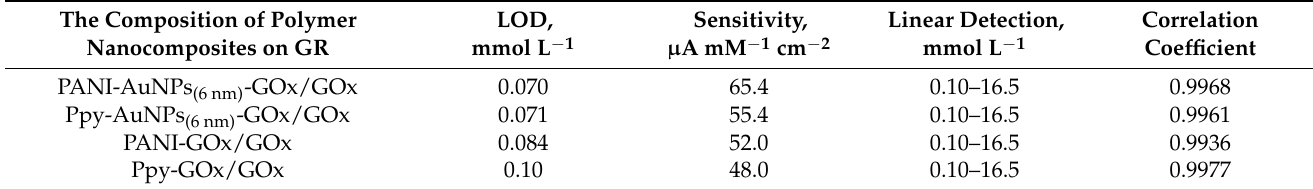
Table 1. The comparison of analytical characteristics of glucose biosensors based on GR/PANI-AuNPs (6 nm) -GOx/GOx, GR/Ppy-AuNPs (6 nm) -GOx/GOx, GR/PANI-GOx/GOx or GR/Ppy-GOx/GOx. All experimental conditions were the same as reported in Figure